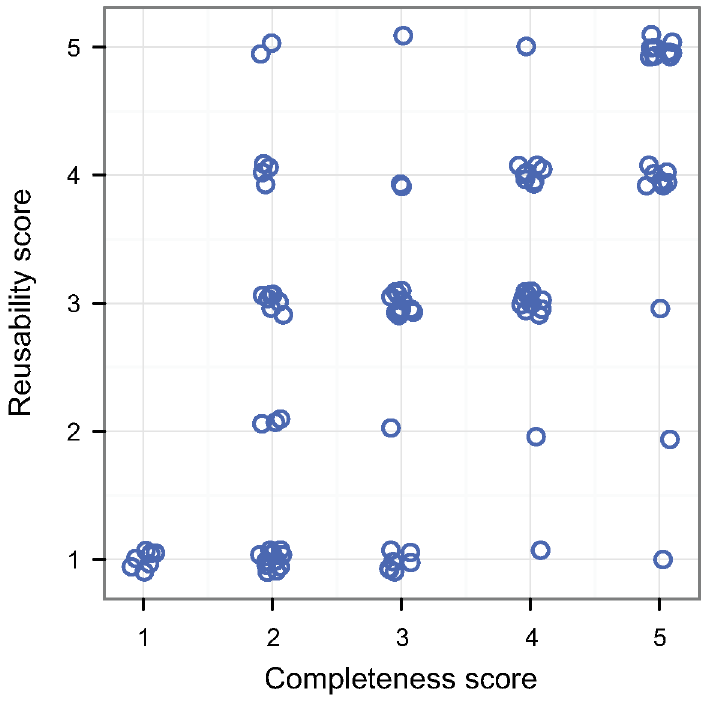
Fig 3. The relationship between the reusability and completeness of archived datasets (R = 0.59, p < 0.001). Empty circles are individual data points (offset to avoid overlap).